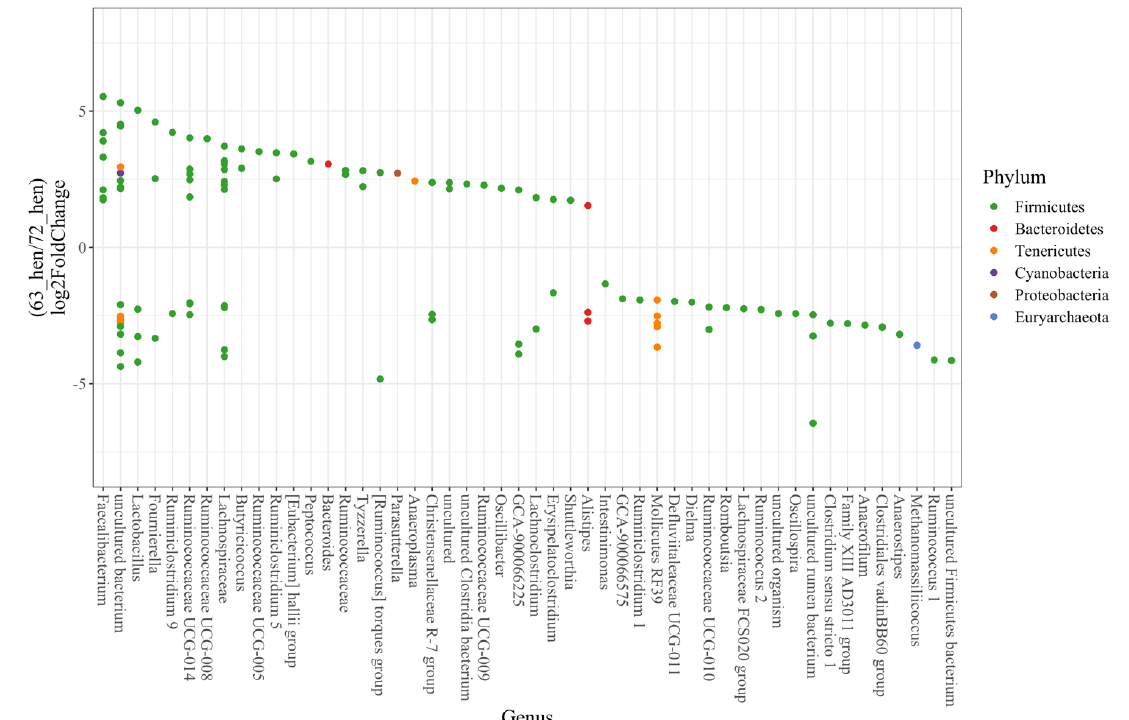
Figure 5. Pairwise comparisons (DESeq2 analysis) between two diversely selected chicken lines (n = 10). Differential abundant OTUs ( p < 0.05) in 6 3 -hen and 7 2 -hen are shown. OTUs were assigned to genus (x- axis) and phylum level (colors). Positive “log 2 Fold Change” values (y -axis) indicate higher abundance in 6 3 -hens, and negative values indicate higher abundance in 7 2 -hens.